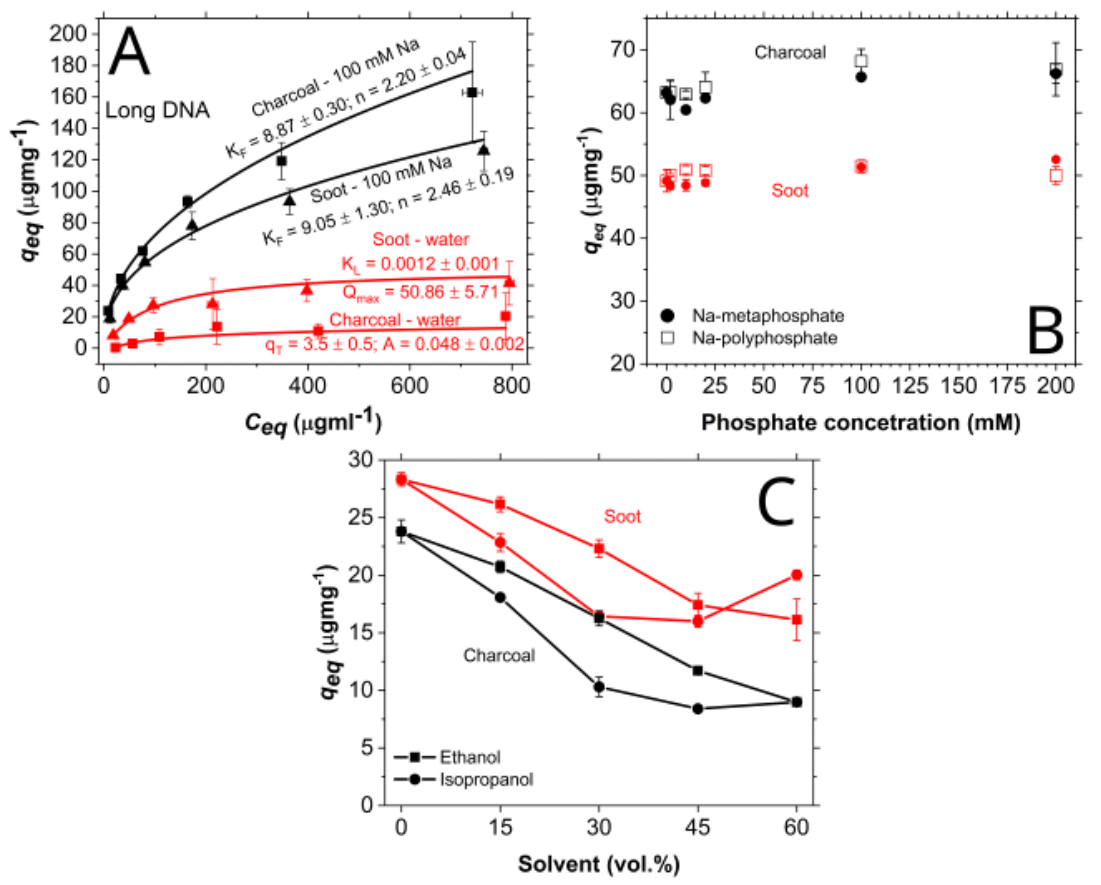
Figure 4. A) Adsorption data (symbols) of <2000 bp salmon sperm DNA and the corresponding isotherm models (lines). The capacity for long DNA is lower than for short DNA. There is a significantly larger